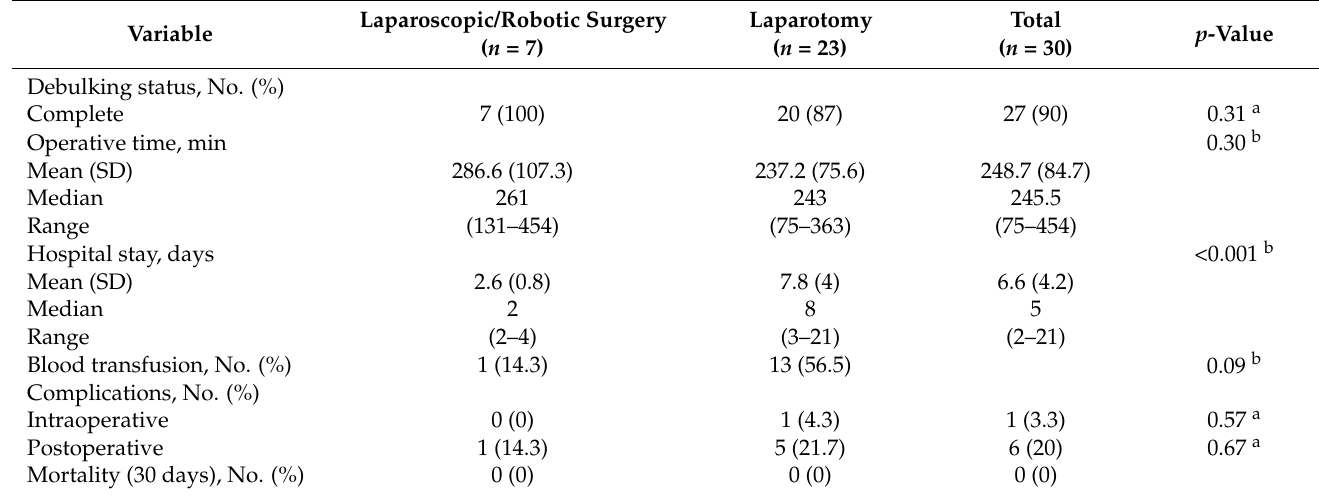
Table 4. Perioperative outcomes for the interval debulking